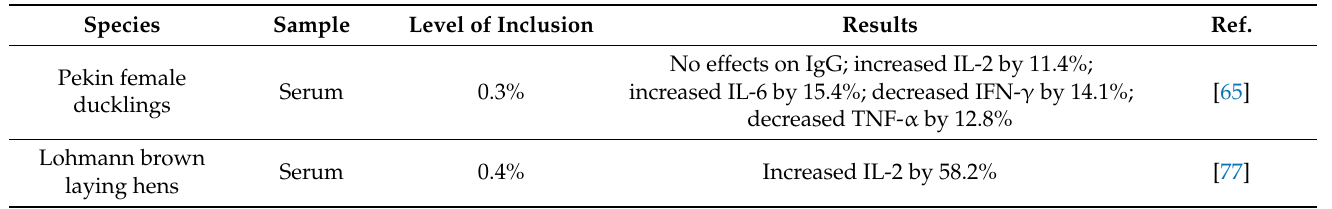
Table 1. MSM inclusion in the diet and its effects on the immune response in comparison with